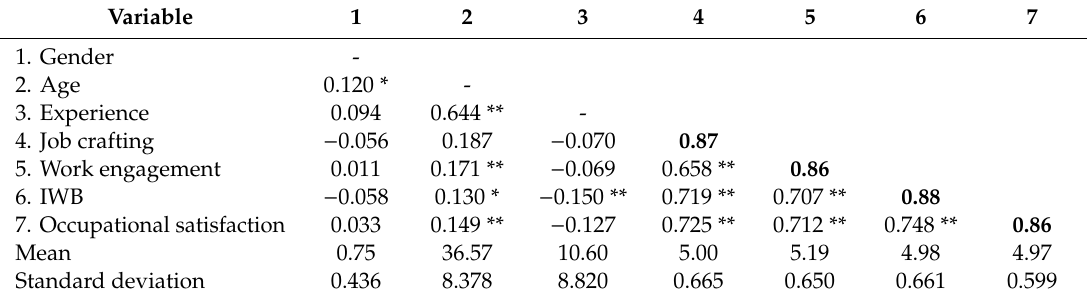
Table 1. Means, standard deviations, inter-correlations, and reliabilities of the study variables.